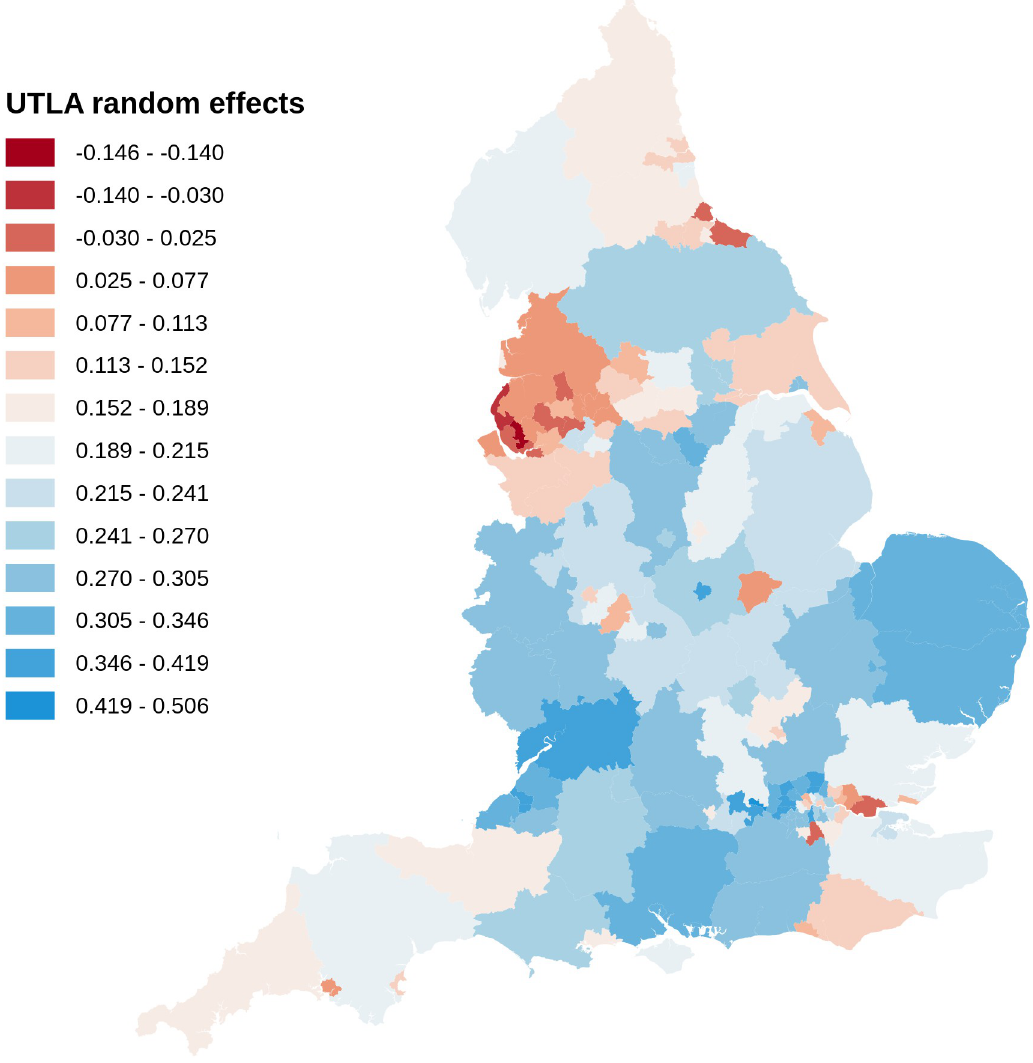
Fig 4. Geography of estimated random effects of Upper Tier Local Authorities, for the Third Injection. A map of England is shown with Upper Tier Local Authorities, each shaded according to the estimated random effect c i using model D for the Third Injection. Areas with red (blue) shading have estimated random effects below (above) the